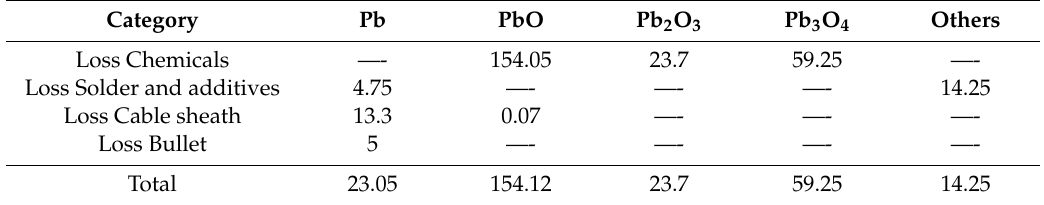
Table 5. The loss of various lead compounds in China’s lead use stage in 2017. (Unit: kilo